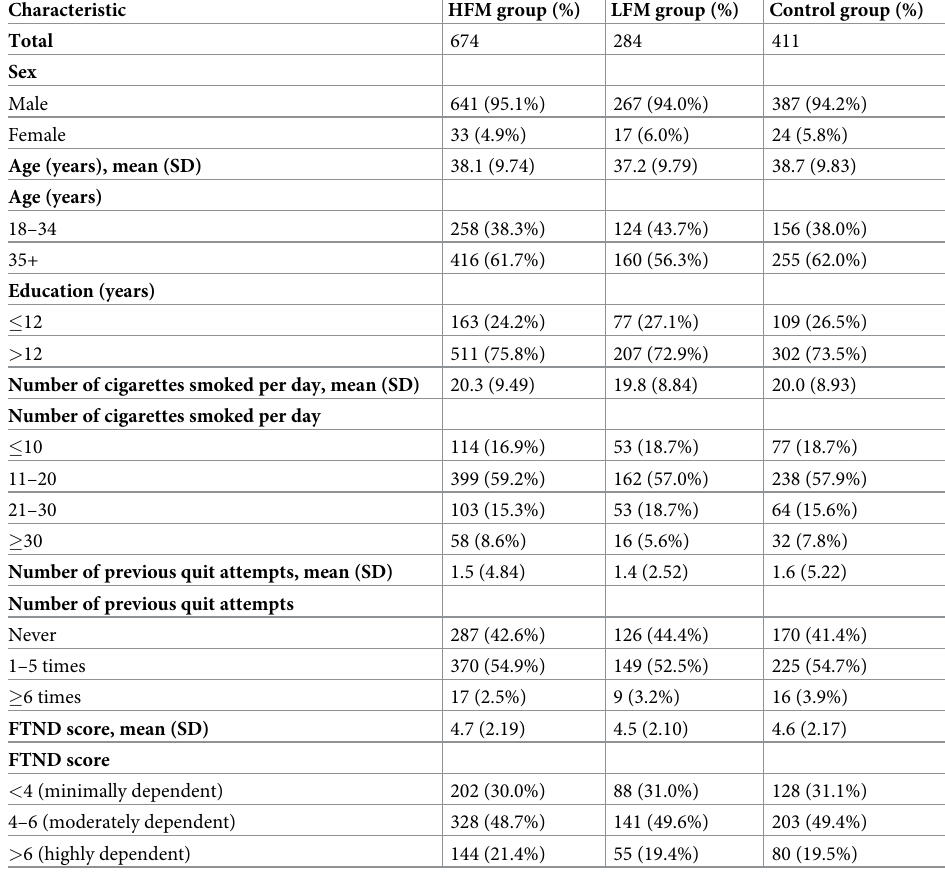
Table 1. Baseline characteristics of study